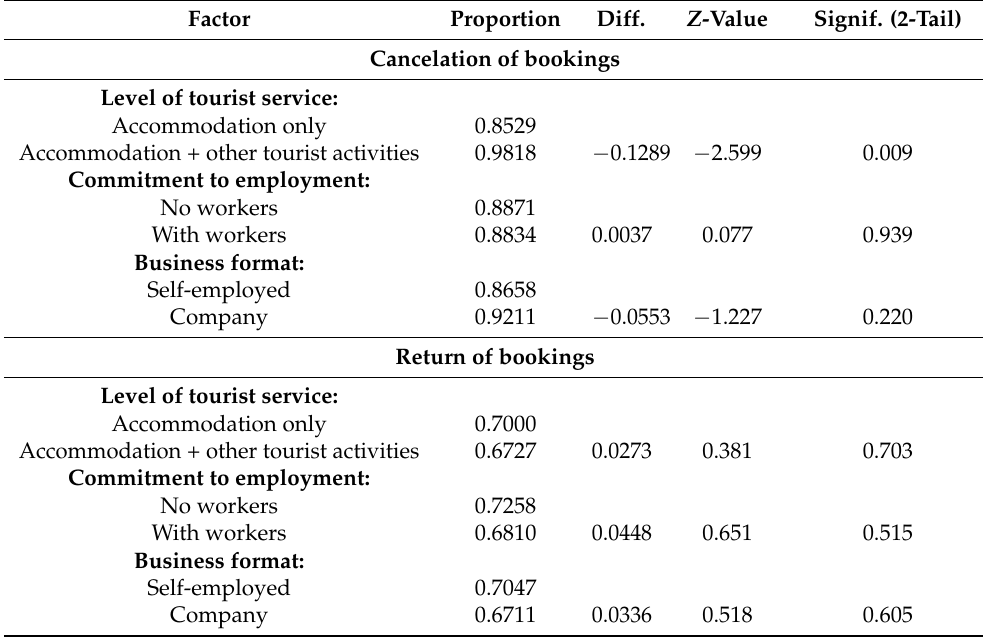
Table 4. Comparison of proportions of the effects of the COVID-19 lockdown on the tourism management of tourist accommodation B: booking management. Factor Proportion